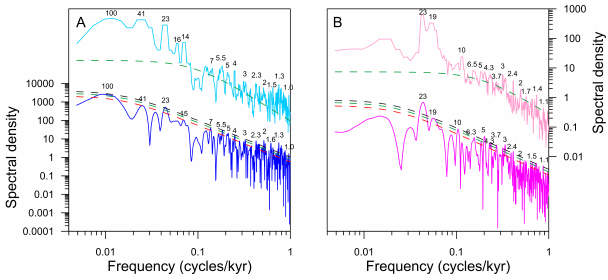
Figure 3. Spectra of Gulang MGS (a) and Sanbao/Hulu speleothem δ 18 O (b) (Wang et al., 2008; Cheng et al., 2009) records using REDFIT (lower) and MTM (higher) methods. The red, green and black dotted lines represent the 80, 90 and 95% confidence levels. Periodicities are shown above the spectral curves. (for REDFIT: nsim = 1000, mctest = T, ofac = 4.0, hifac = 1, rhopre =− 99.0, n50 = 1, iwin = 2; for MTM: sampling interval = 0.1, MTM pa- rameters = default value, computation of tapers window = default value, median smoothing window width = 0.1).